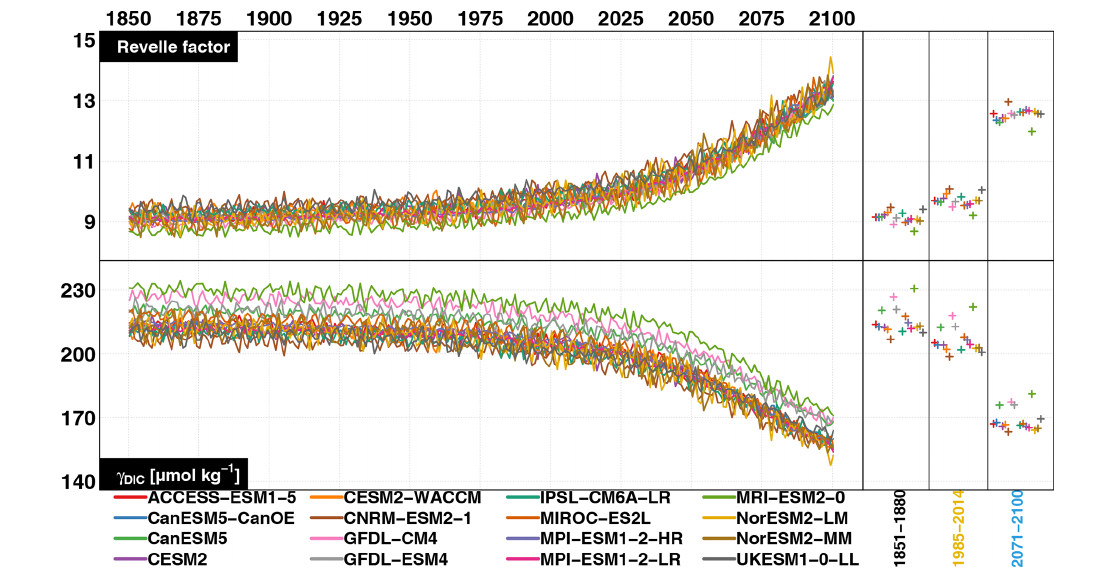
Figure 1. Annual Revelle factor and γ DIC (in µmolkg − 1 ) for CMIP6 models. Average Revelle factor for each ESM over the early historical (1851–1880), contemporary (1985–2014), and future (2071–2100) periods are given on the right-hand side of the figure..